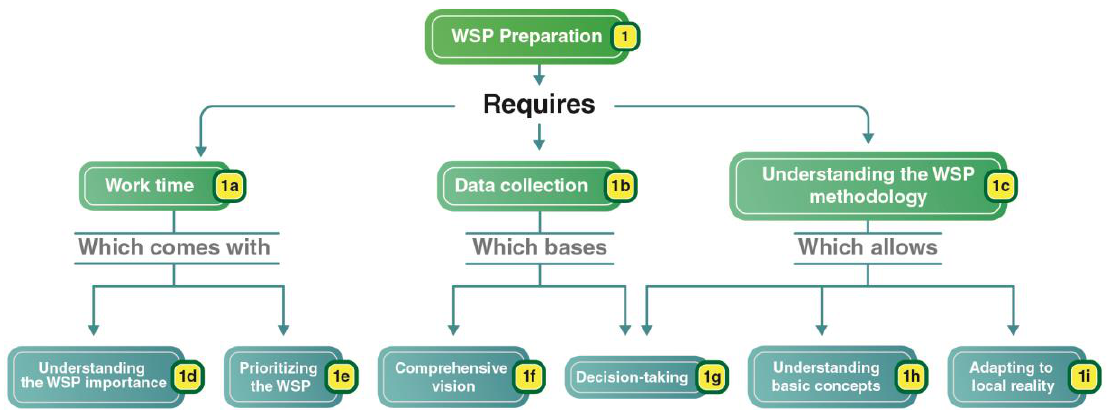
Figure 5. Requirements for the preparation of water safety plans (WSP) that impact its implementation (drafted by the author).